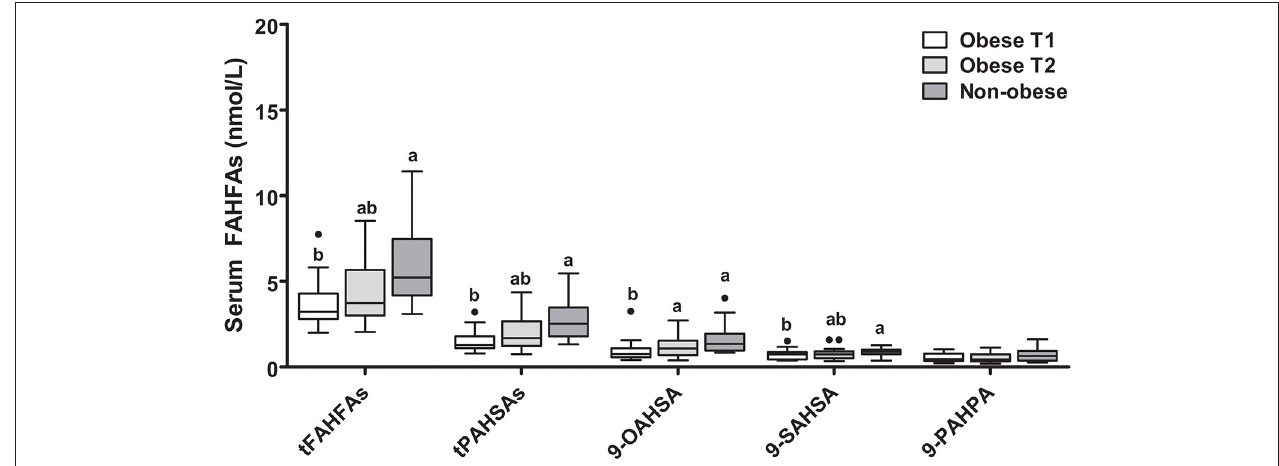
FIGURE 2 | FAHFA concentrations in morbidly obese individuals before and 6 months after laparoscopic sleeve gastrectomy compared to non-obese volunteers. Wilcoxon matched-pairs test was used to compare obese patient before and after surgery (Obese T1 and Obese T2) and Mann-Whitney test to compare obese patients with non-obese patients. Box plots describe the median and the 25th percentile and 75th percentile. n = 18 per group. Labeled medians without a common superscript letter differ, P < 0.05. t, total (sum of FAHFAs/PAHSAs measured); FAHFA, fatty acid ester of hydroxy fatty acid; OAHSA, oleic acid-hydroxy stearic acid; PAHPA, palmitic acid-hydroxy palmitic acid; PAHSA, palmitic acid-hydroxy stearic acid; SAHSA, stearic acid-hydroxy stearic